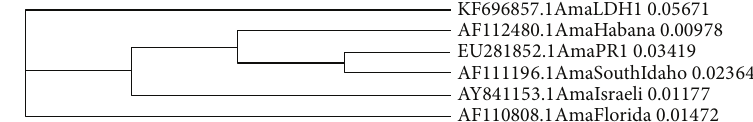
Figure 7: Phylogenetic relationship of local strain (KF696857.1) for the partial msp1b coding sequences of different strains of Anaplasma marginale